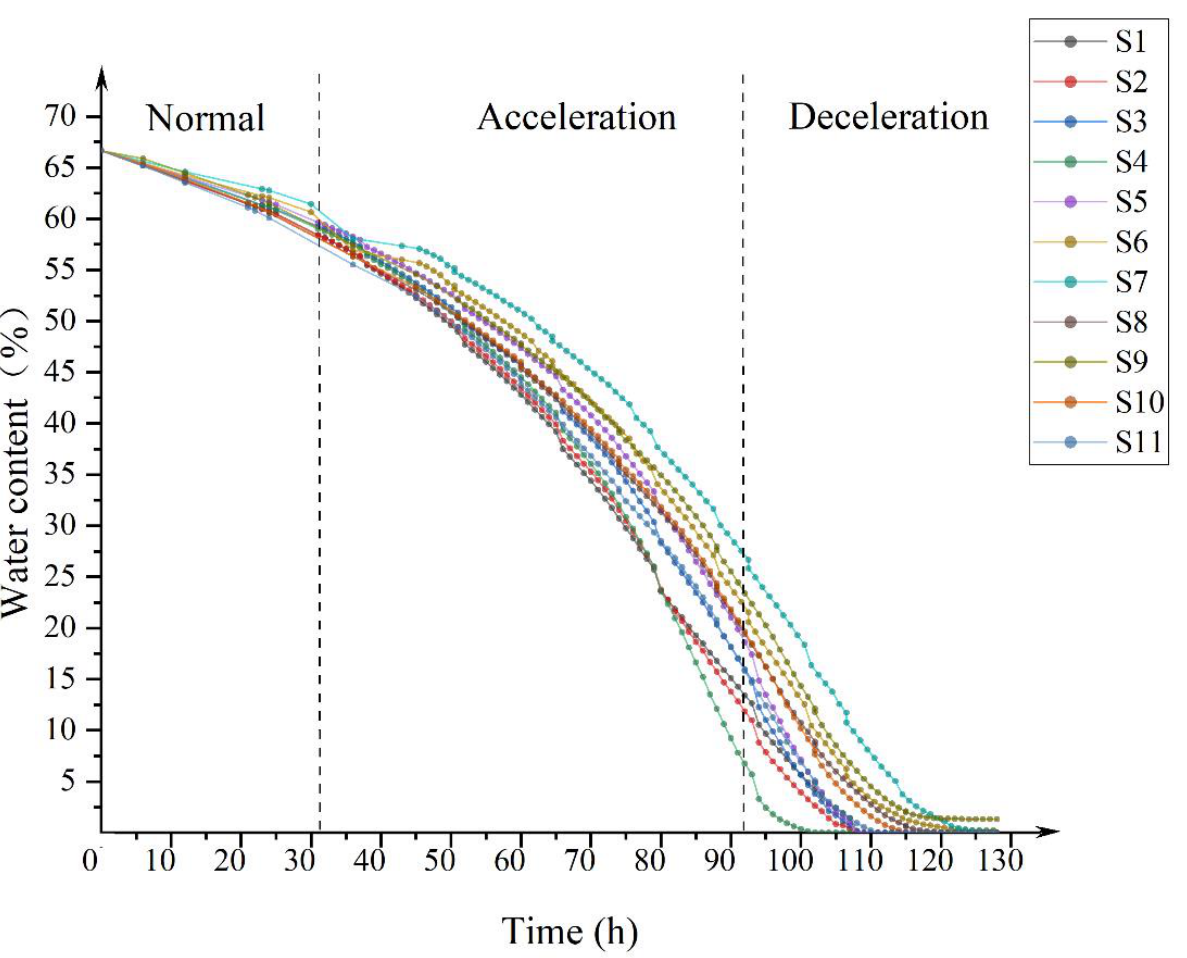
Figure 2. Changes in water content versus time. According to the change rate of water content, it is divided into normal, acceleration and deceleration stages.